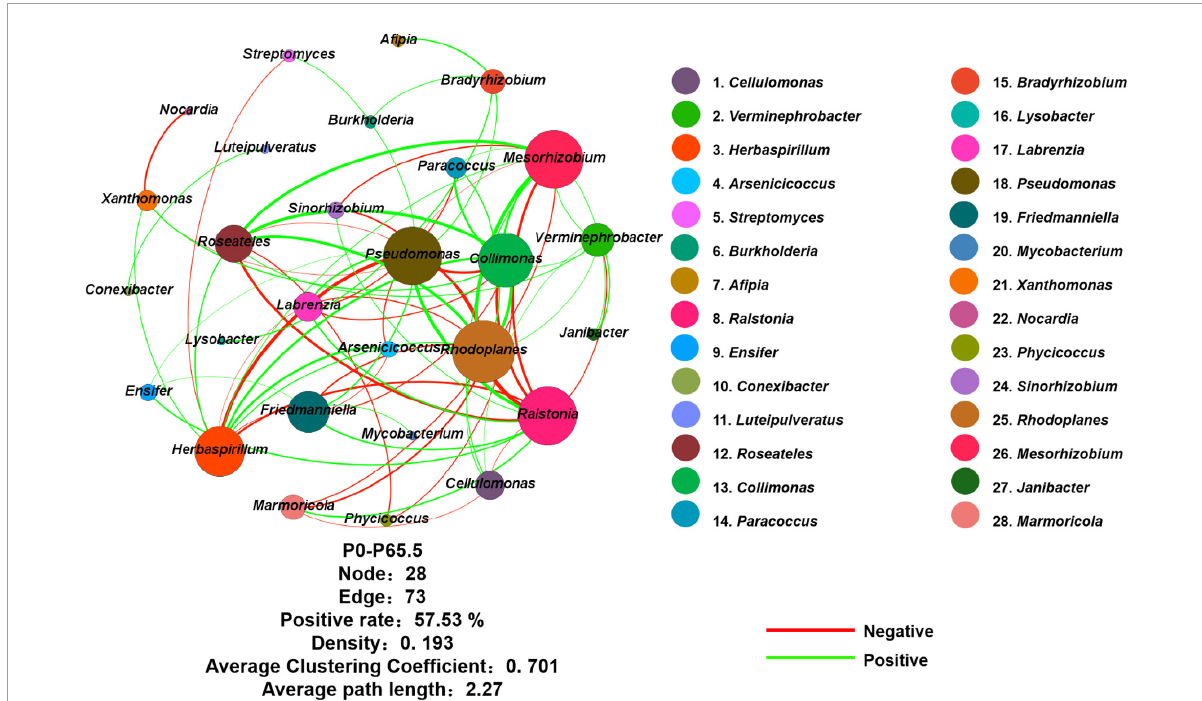
FIGURE4 Network of phoD -harboring bacteria based on Spearman correlation analysis from OTU profiles. The network consists of five gradient phosphorus fertilization rates (including P0, P16, P33, P49, and P65.5). The color of the nodes represents the taxa of the genus classification. Red lines represent a positive correlation, and green lines indicate a negative correlation. Node, edge, positive rate, density, average clustering coefficient, and average path length of the topological parameters were shown below the network. P0, P16, P33, P49, and P65.5 represent 0, 16, 33, 49, and 65.5 kg P ha − 1 , respectively.